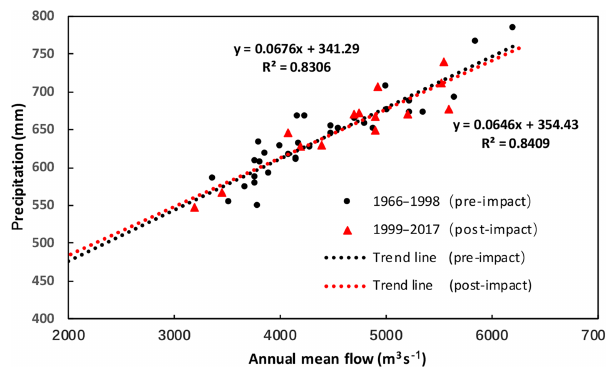
Figure 7. Correlation between runoff and precipitation for the peri- ods of pre- and post-impact in Panzhihua